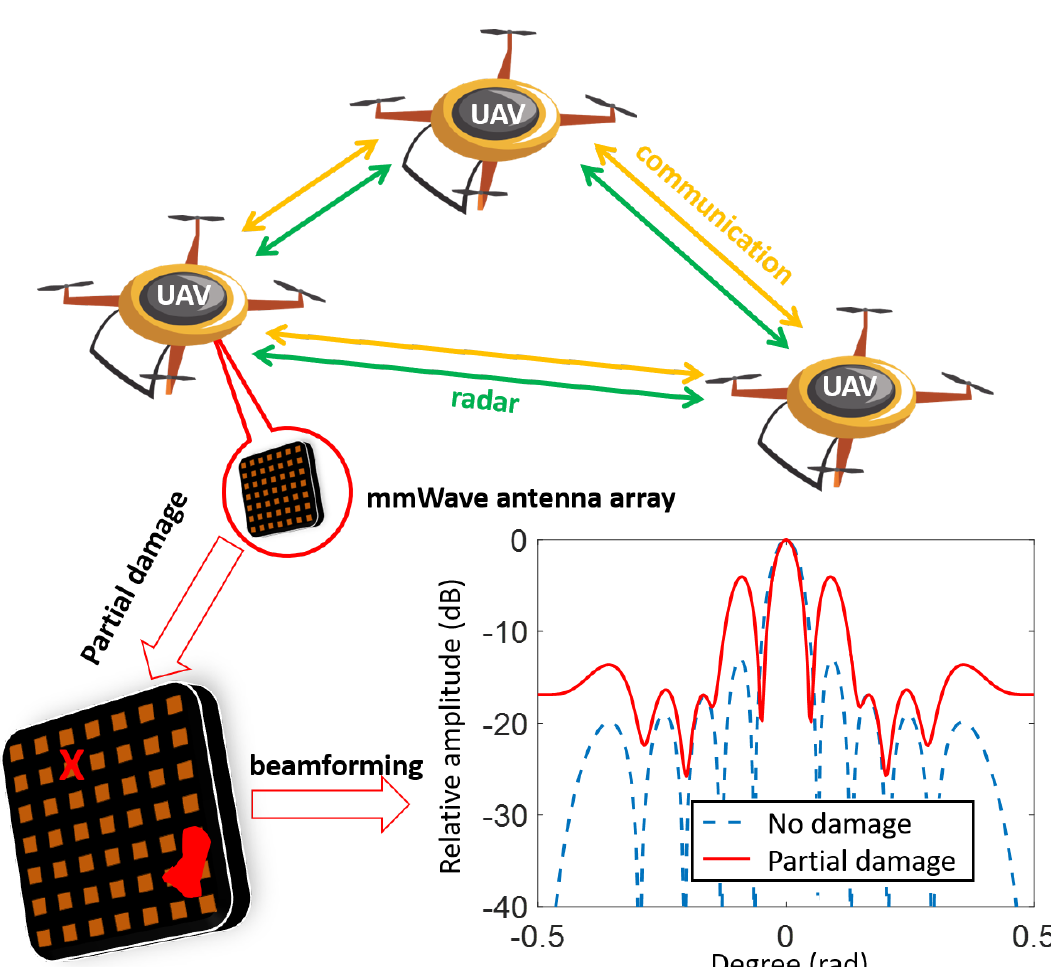
Figure 1. Diagram of joint radar-communication system for UAV clusters and the influence of the failed array elements. The graph in the lower right corner is the comparison of the antenna pattern with or without the failed element. The x-axis indicates the direction of the incoming signal, and the y-axis indicates the relative gain of the